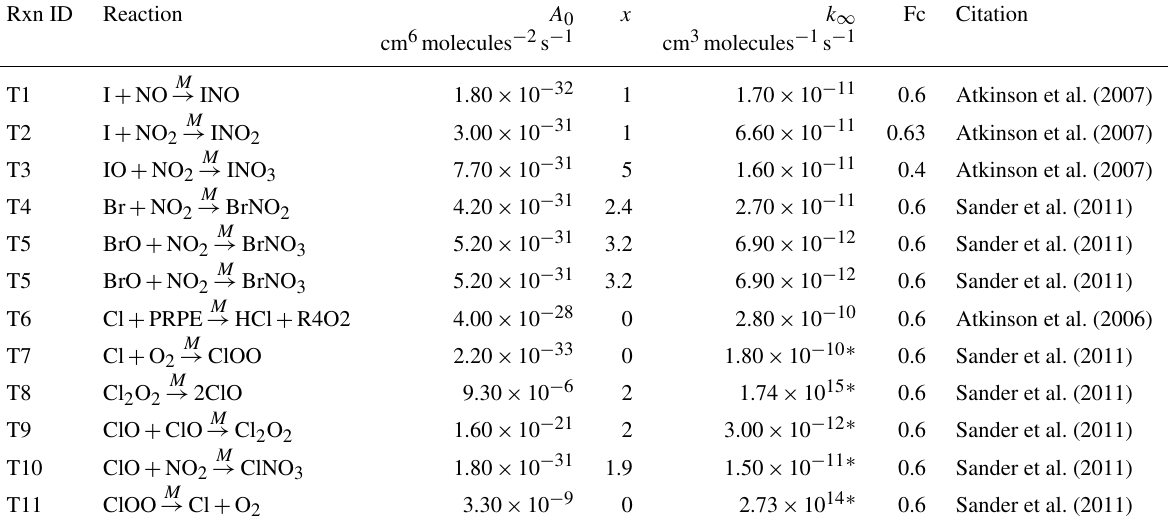
Table B3. Termolecular halogen reactions included in the scheme. This includes reactions from previous updates to halogen chemistry in GEOS-Chem (Eastham et al., 2014; Parrella et al., 2012; Schmidt et al., 2016; Sherwen et al., 2016a) and those detailed in Sect. 2. The lower ) x . The high pressure limit is given by k ∞ . Fc characterises the fall off curve of the reaction as pressure limit rate ( k 0 ) is given by A 0 · ( 300 T described by Atkinson et al.